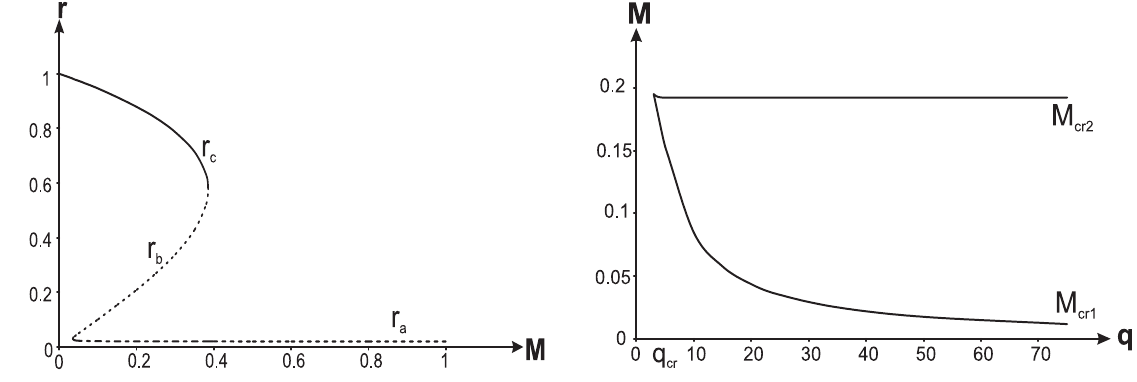
Figure 4. Generic form of the horizons-mass diagram ( left ) and dependence of critical masses on the parameter q ( right